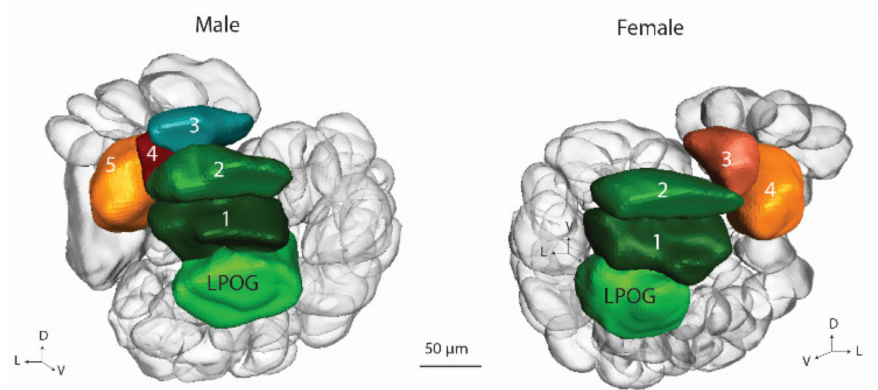
Figure 6. Three-dimensional reconstruction of the ventroposterior glomeruli (VPx) and the labial pit organ glomerulus (LPOG) in the male and female antennal lobe of the